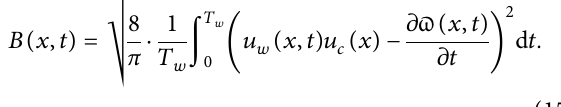
Figure 1: Physical model of an offshore drilling riser element under lateral